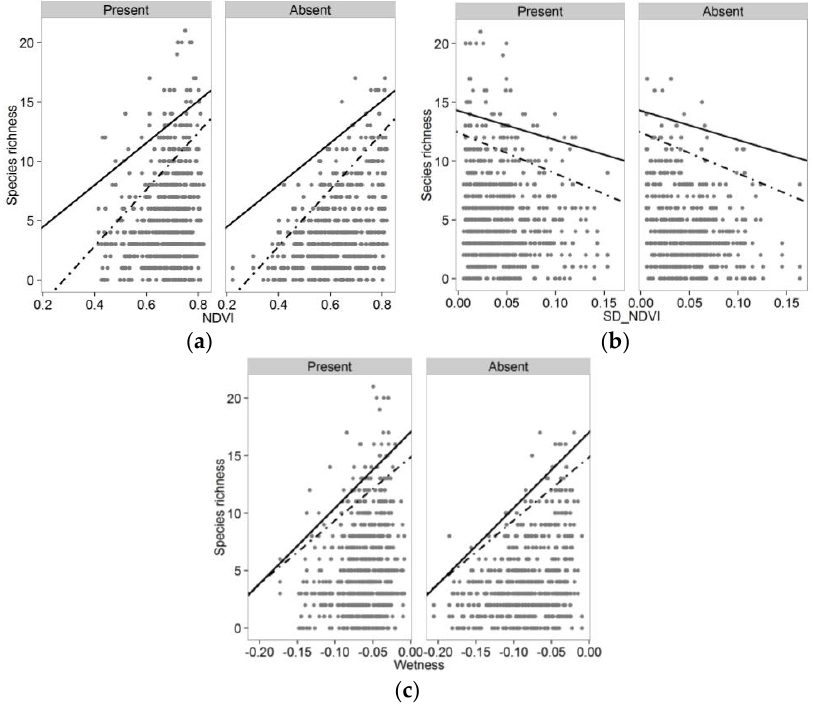
Figure 6. Quantile regression (tau = 0.95) between for species richness with ( a ) NDVI; ( b ) standard deviation of NDVI; ( c ) wetness index under presence or absence of local institutions. The dashed line represents fitted values in villages without local institutions and the solid line is for villages with local institutions.